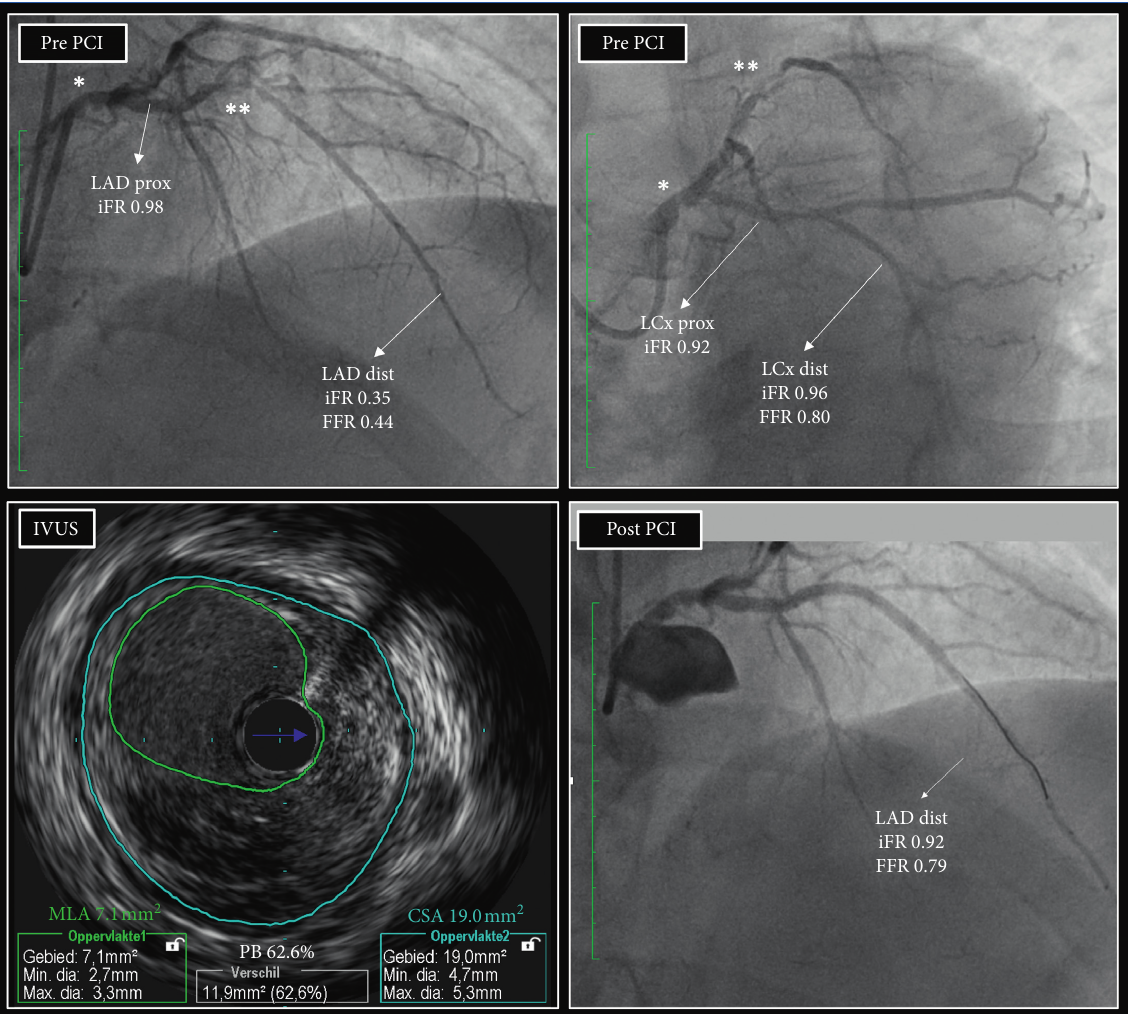
Figure 1: A practical example of a LM lesion with downstream disease. A patient with effort angina had a LM lesion ( ∗ ) which appeared angiographically at least moderate, but also a severe lesion at the level of the mid LAD ( ∗∗ ) . The LCx showed some disease but was clearly the least affected daughter branch of the LM. iFR distal to LAD was 0.35, indicating flow-limiting disease upstream, but assessment of the iFR along the course of the LAD revealed that the drop in iFR was mainly caused by the mid LAD lesion. In the proximal part of the LAD, the iFR was 0.92, suggesting that the LM lesion was not physiologically significant. iFR in the LCx was 0.92 in the proximal part and 0.96 in the distal part, which seemed to confirm this. However, since the disease in the LAD was so severe that it may also have been flow-limiting at rest, stable resting conditions may have been absent and, theoretically, the iFR might have been lower at that level if the downstream disease was not so critical. FFR towards LAD was 0.44, also indicating critical disease upstream. FFR towards LCx was 0.80, borderline significant. Since the disease in LAD was severe and the value was below 0.85, the LM lesion might still have been flow-limiting. Given the iFR and FFR findings, the operators decided to also evaluate the LM lesion with IVUS. The MLA was 7.1mm 2 (above 6.0mm 2 ), and the operators decided to defer the LM, treat the LAD lesion, and repeat physiological assessment. After PCI, the result was good by IVUS, and the iFR was 0.92. FFR was 0.79, just below 0.80 but above 0.75. Maximal preventive treatment was installed and, 20months later, the patient is still asymptomatic and event free. Because of the disease in the LM (plaque burden, PB, on IVUS was 62%) and the final FFR value, the operators did plan a follow-up angiography with physiological assessment and IVUS 2 years after the index procedure. LM: left main; LAD: